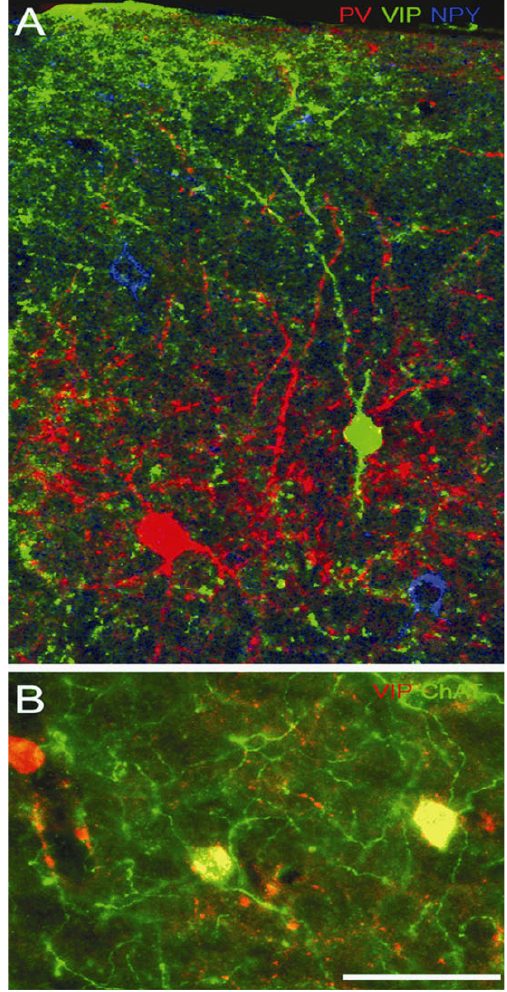
Figure 4. Triple immunolabeling with antibodies against PV, VIP, NPY and ChAT in adult mouse visual cortex. (A) Coronal section through super- fi cial layers of V1, showing expression of PV (red), VIP (green) and NPY (blue) in separate populations of neurons. (B) VIP and ChAT expression in layer 2/3 of V1. All ChAT immunoreactive neurons express VIP (yellow), but ChAT is present only in subset of VIP neurons. Scale: 25 μ